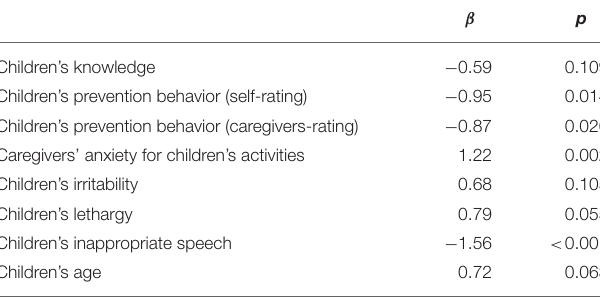
TABLE 3 | The result of step-wise regression analysis on children’s fear of COVID-19.